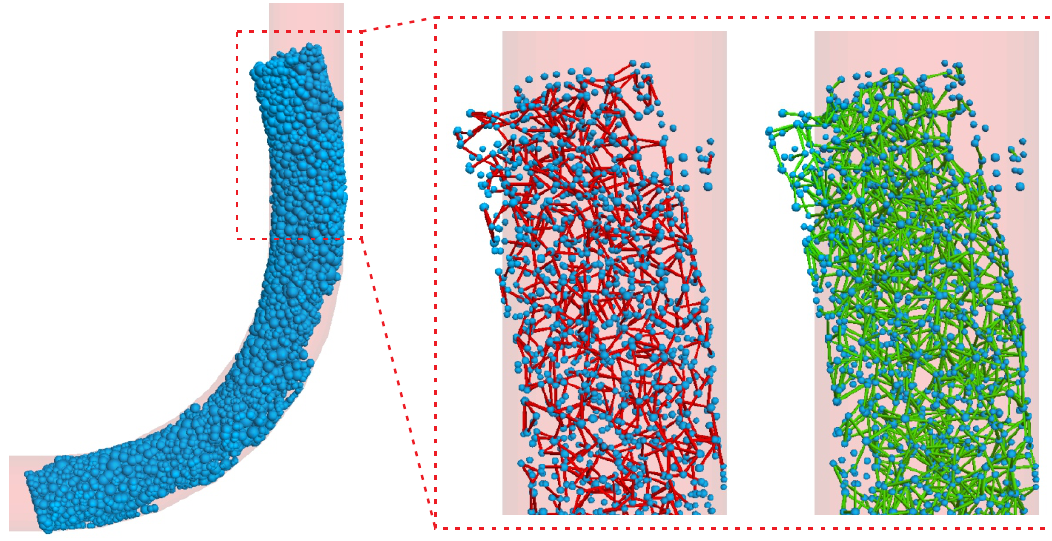
Figure 18. Simulation results with respect to hydration: The excessive case of 20% contacts hydrated with ¯ E ∗ = 1.0 × 10 9